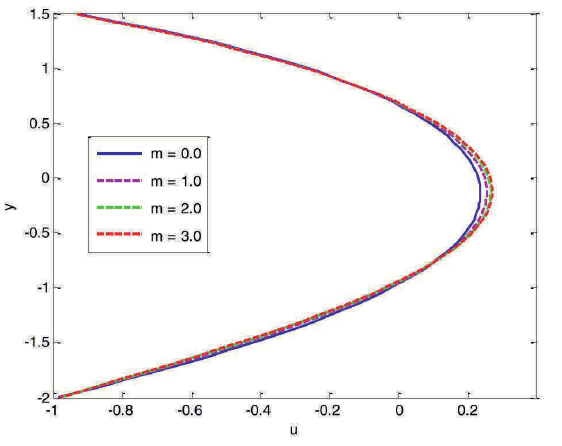
Fig. 9: Impact of second order velocity slip parameter β 2 on